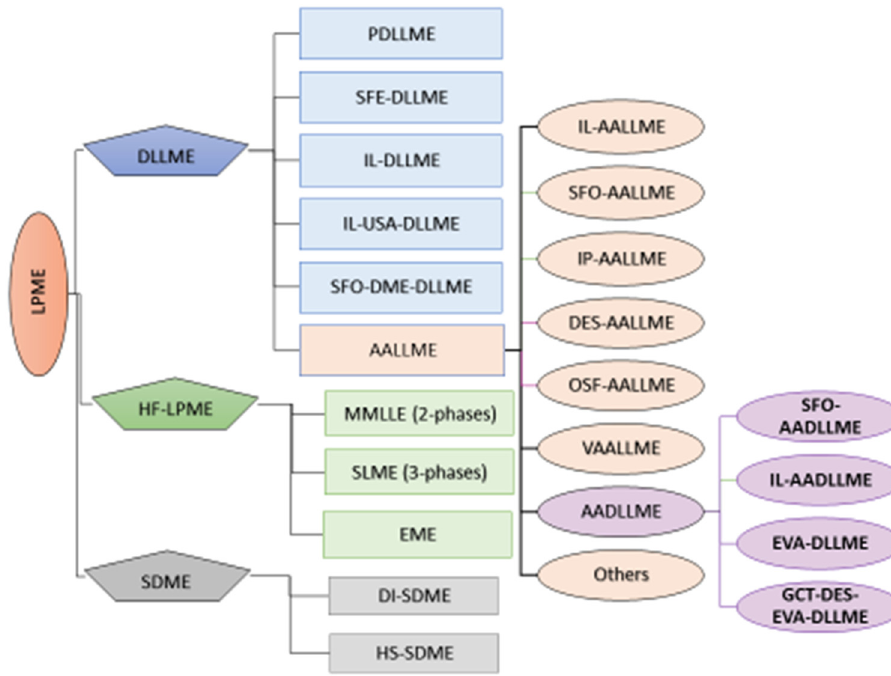
Figure 1: Classi fi cation of LPME and AALLME